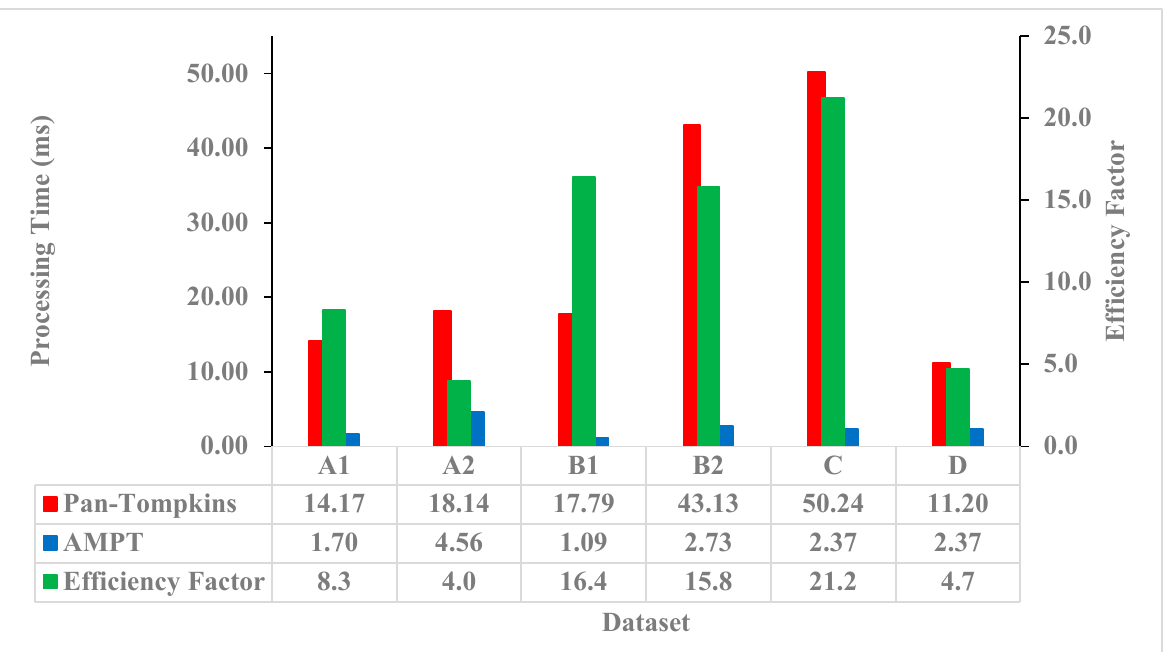
Figure 1. Processing times per ten seconds of ECG data for the Pan–Tompkins (red) and AMPT (blue) algorithms with their efficiency factors (green) by dataset. A1 = High Quality, A2 = Low Quality, B1 = Normal Sinus Rhythm, B2 = Arrhythmias, C = Paced Rhythm, and D = TeleHealth datasets.